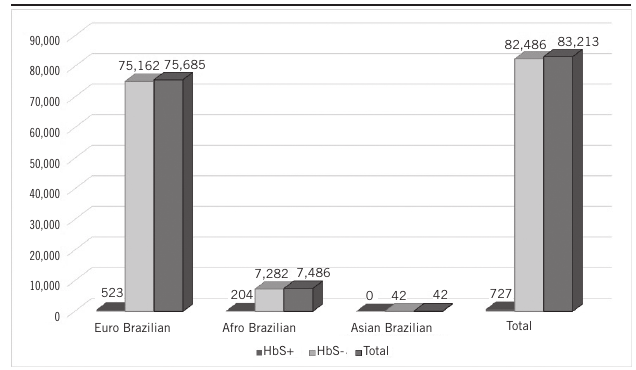
figuRE 2 − Distribution graph of HbS among blood donors, grouped according to ethnic group HbS+: positive hemoglobin S; HbS-: negative hemoglobin S.; HbS: hemoglobin